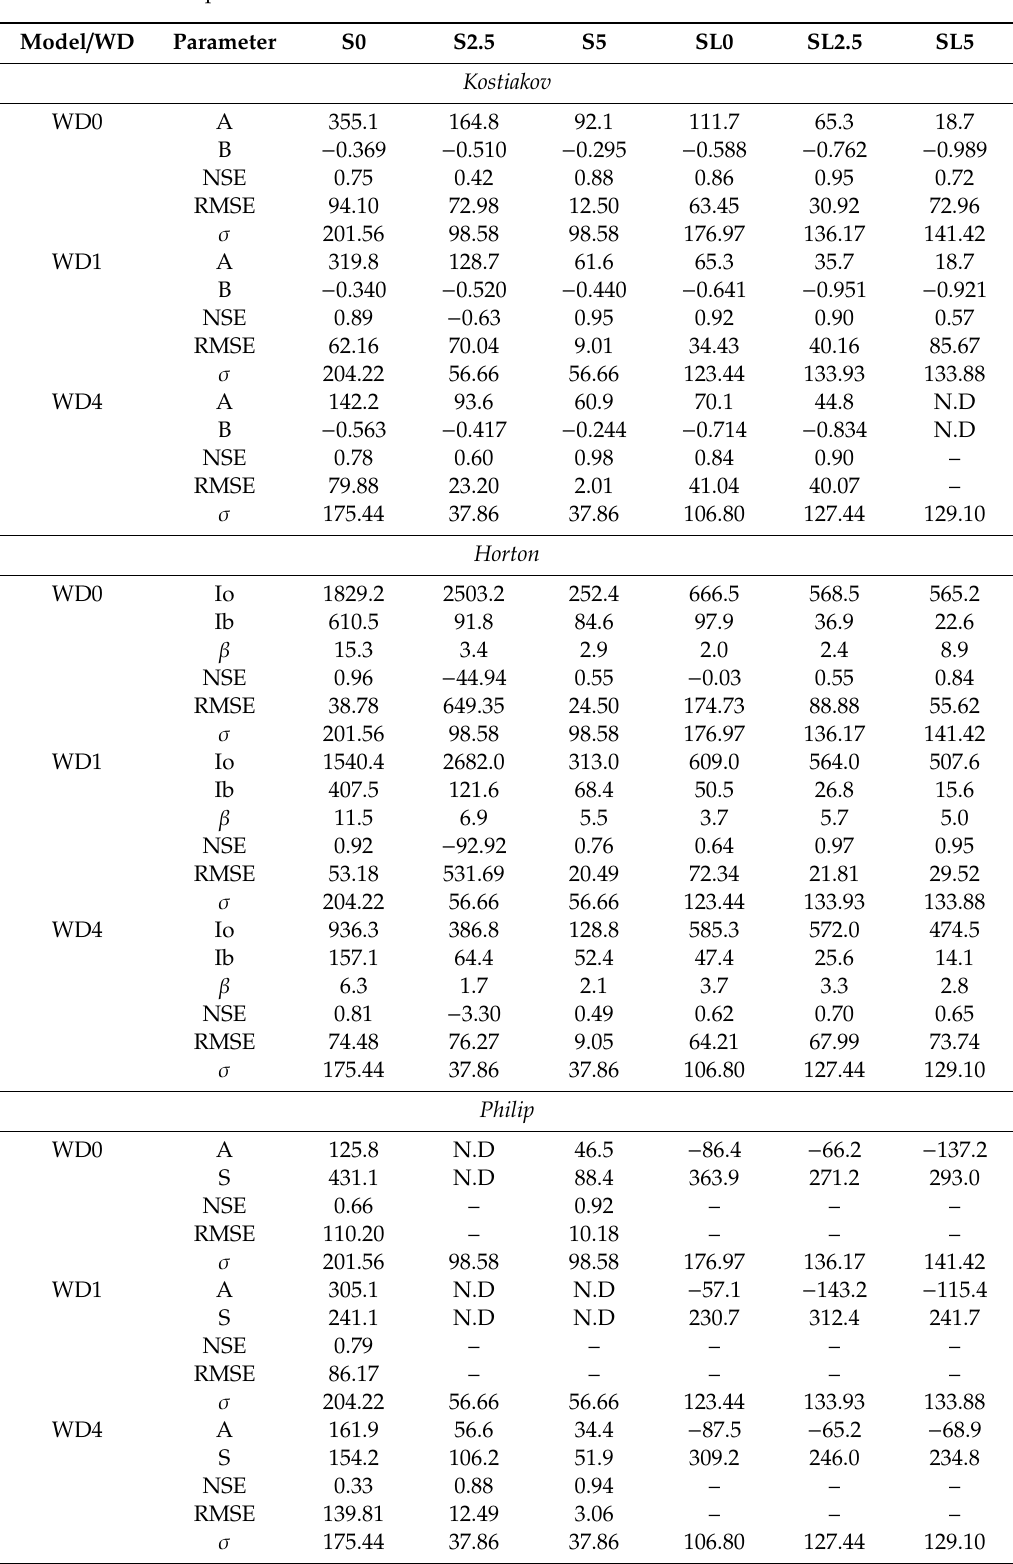
Table 5. Mean infiltration model parameters obtained from the Kostiakov, Horton and Philip models; for the sandy (S) and sandy loam (SL) treatments during two extreme wetting and drying (WD) cycles WD1 and WD4 compared to the initial WD condition